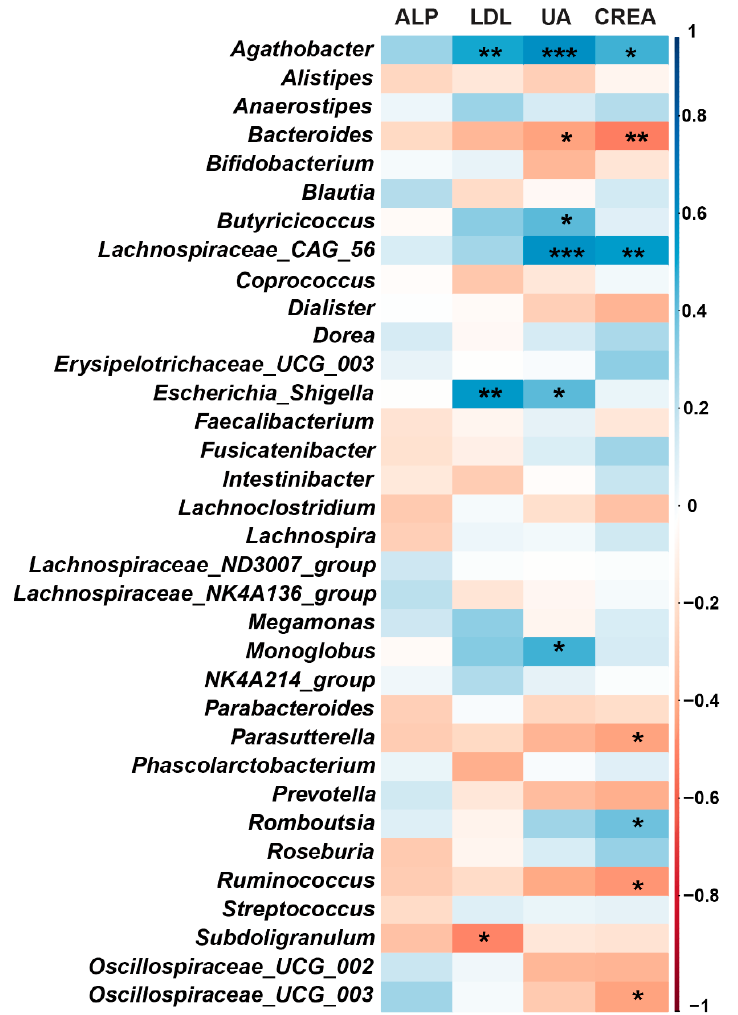
Figure 5. Correlation between gut microbiota at the genus level and serum biochemical indices. Heatmap representing color-coded Spearman’s correlations of the indices. Blue indicates a positive correlation whereas red indicates a negative correlation. The deeper the color, the stronger the positive or negative correlation. * p < 0.05, ** p < 0.01, *** p < 0.001.